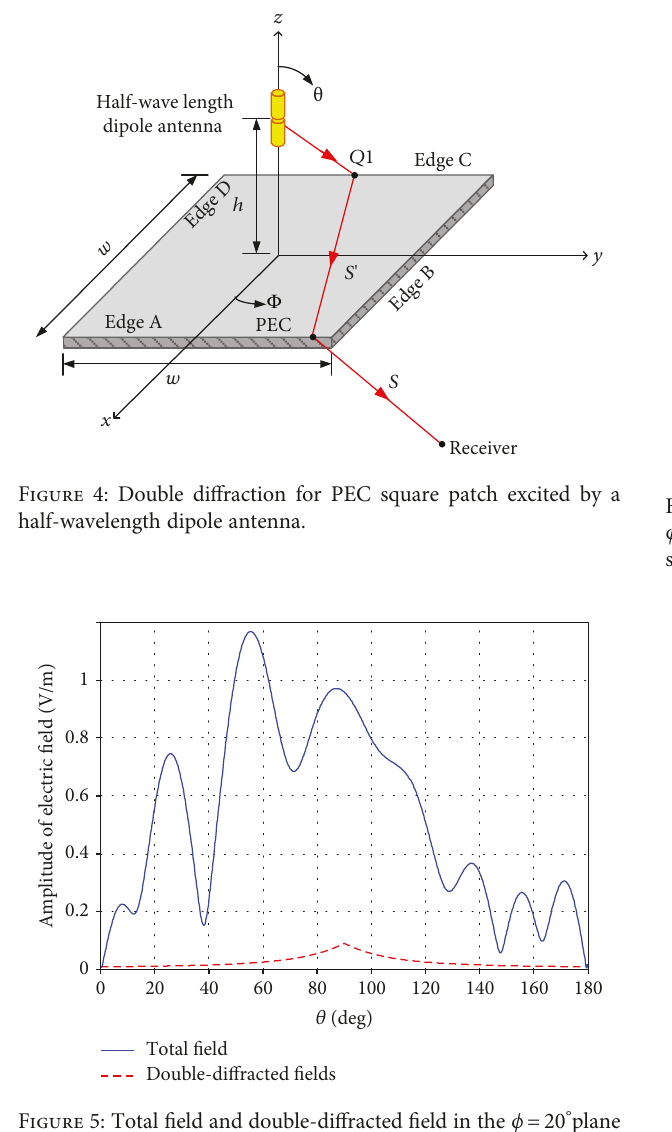
Figure 7: Phase of electric fi eld of the θ component in the ϕ =20 ° plane with w =4 λ and h =1 λ , at 4GHz compared with simulation